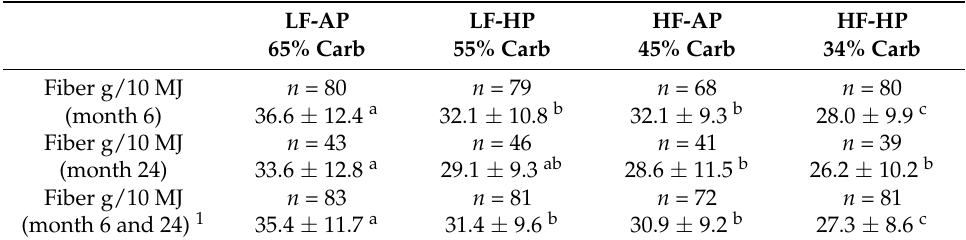
Table 3. Self-reported dietary fiber intake in the four randomized groups.